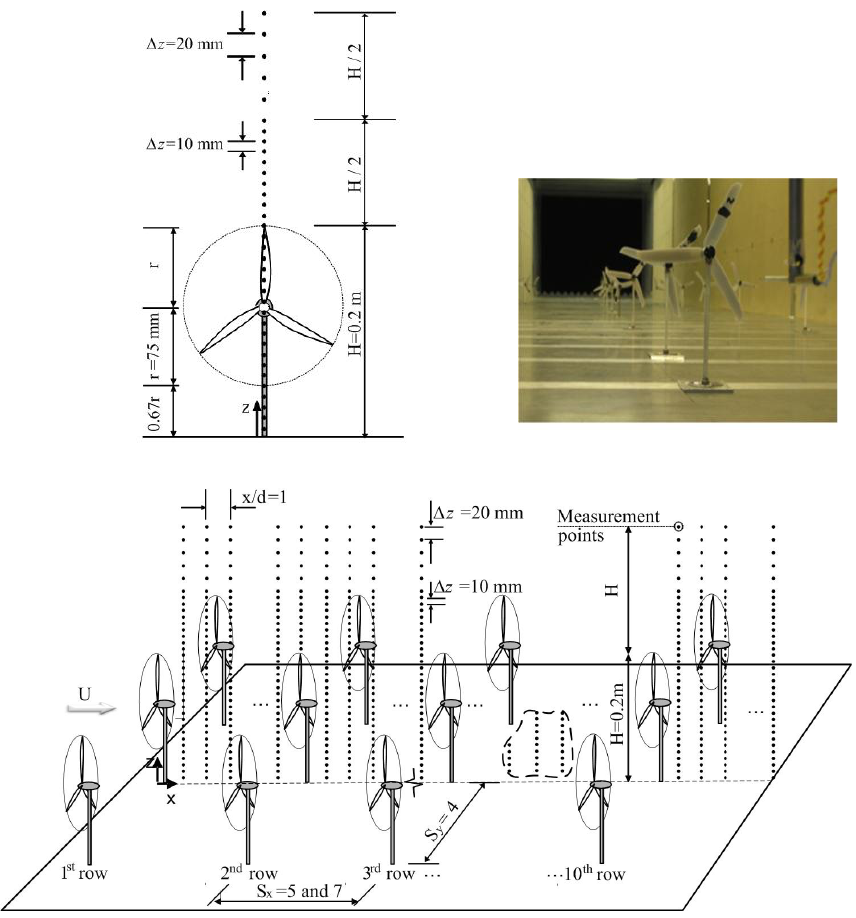
Figure 1. Schematic of the 10 by 3 wind turbine array. Turbine dimensions and measurement locations ( top left and bottom ), and photograph of the test section with the turbines ( top right